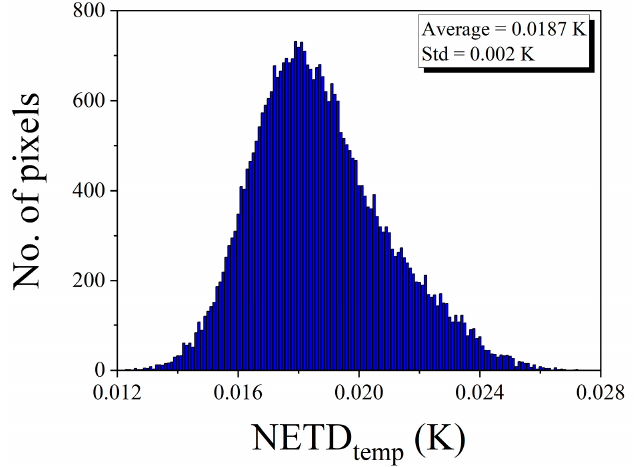
Figure 7. The histogram of temporal NETD of the portable and large-area blackbody system.